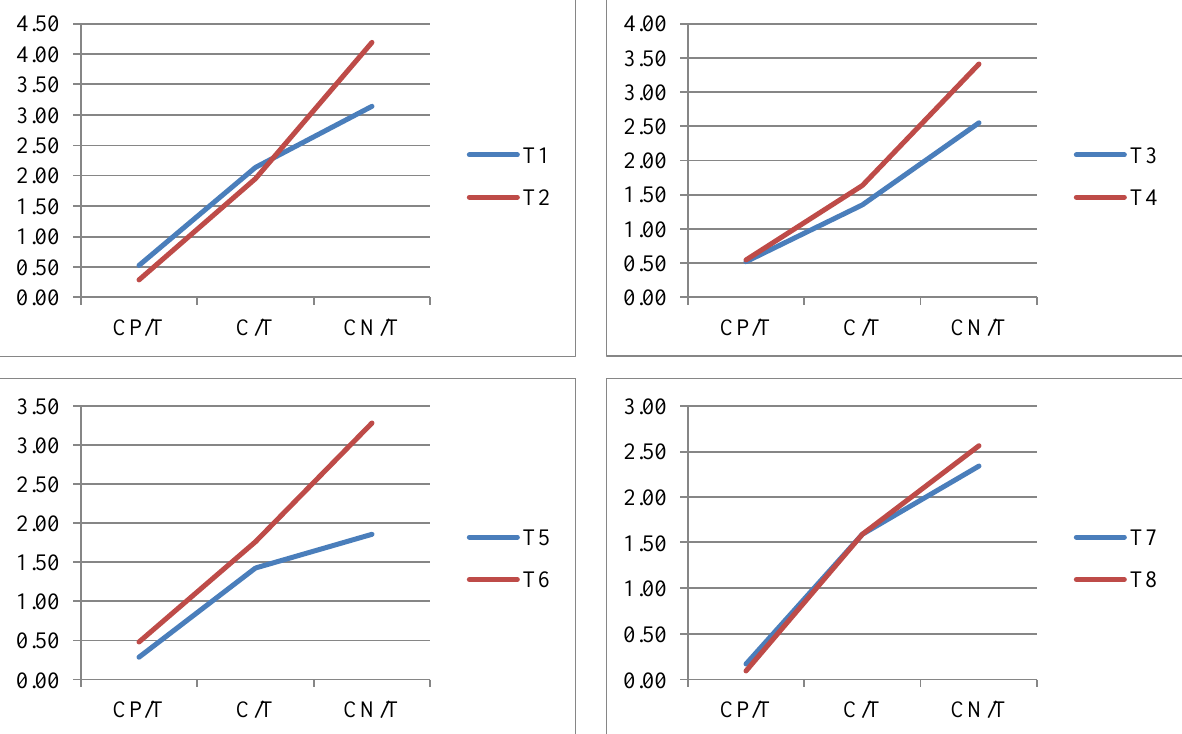
Note. Blue = high school texts; red = college texts.